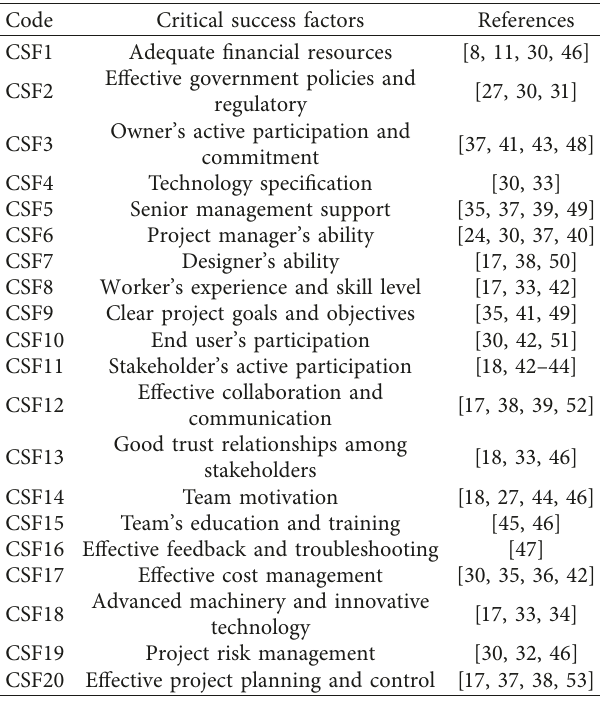
Table 1: Critical success factors for